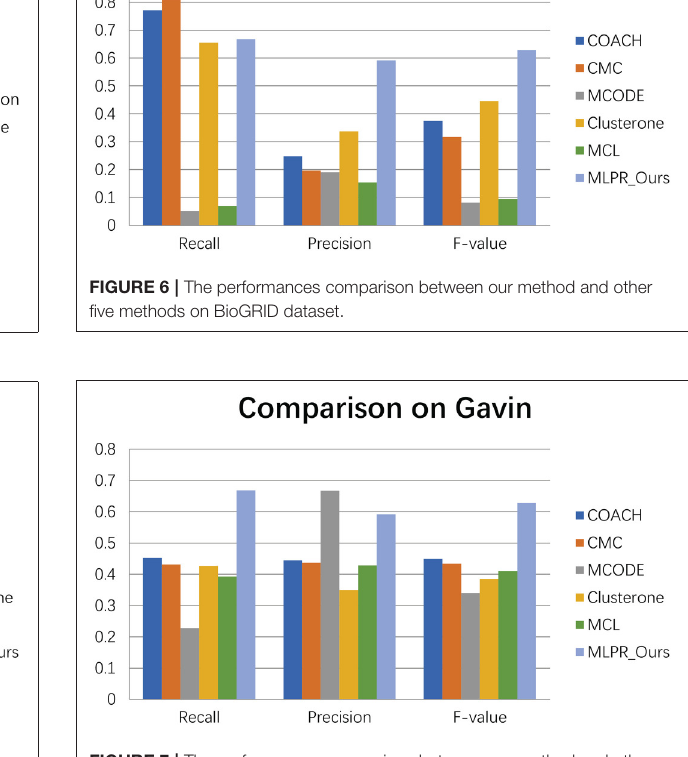
FIGURE 4 | The performance of our MLPR method on our reconstructed PPINs.